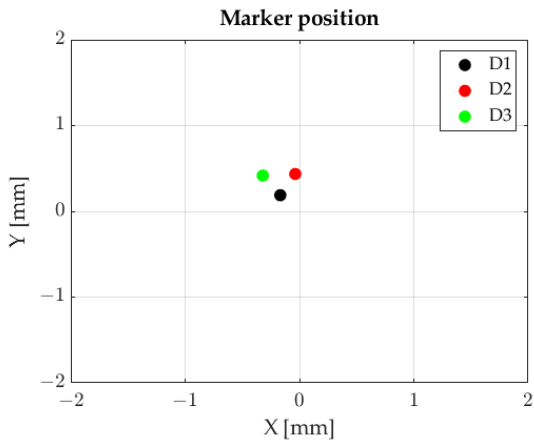
Figure 13. Markers ’ positions, FFT method.